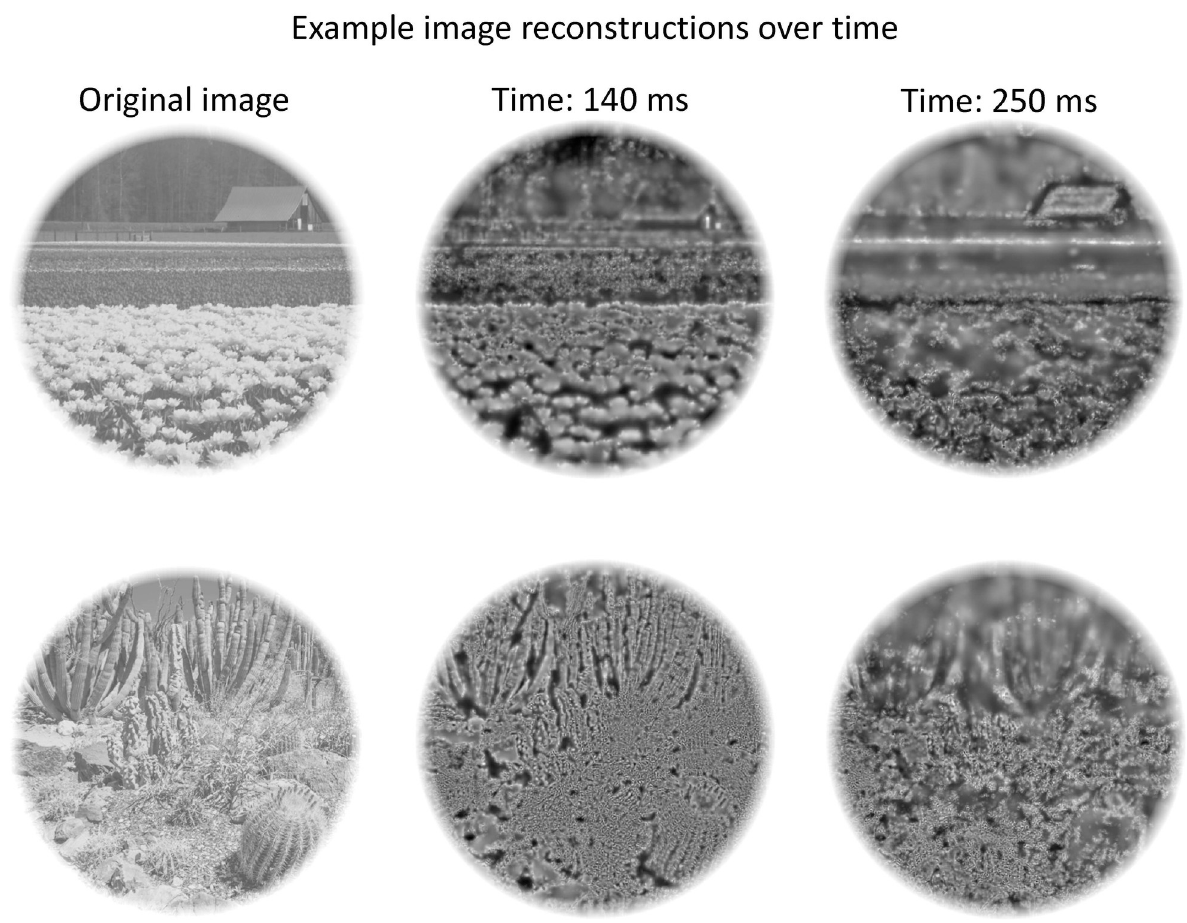
Fig 15. Example stimuli along with their SF filter reconstructions based on the 2D encoder histograms at two time points (see Materials & Methods for further